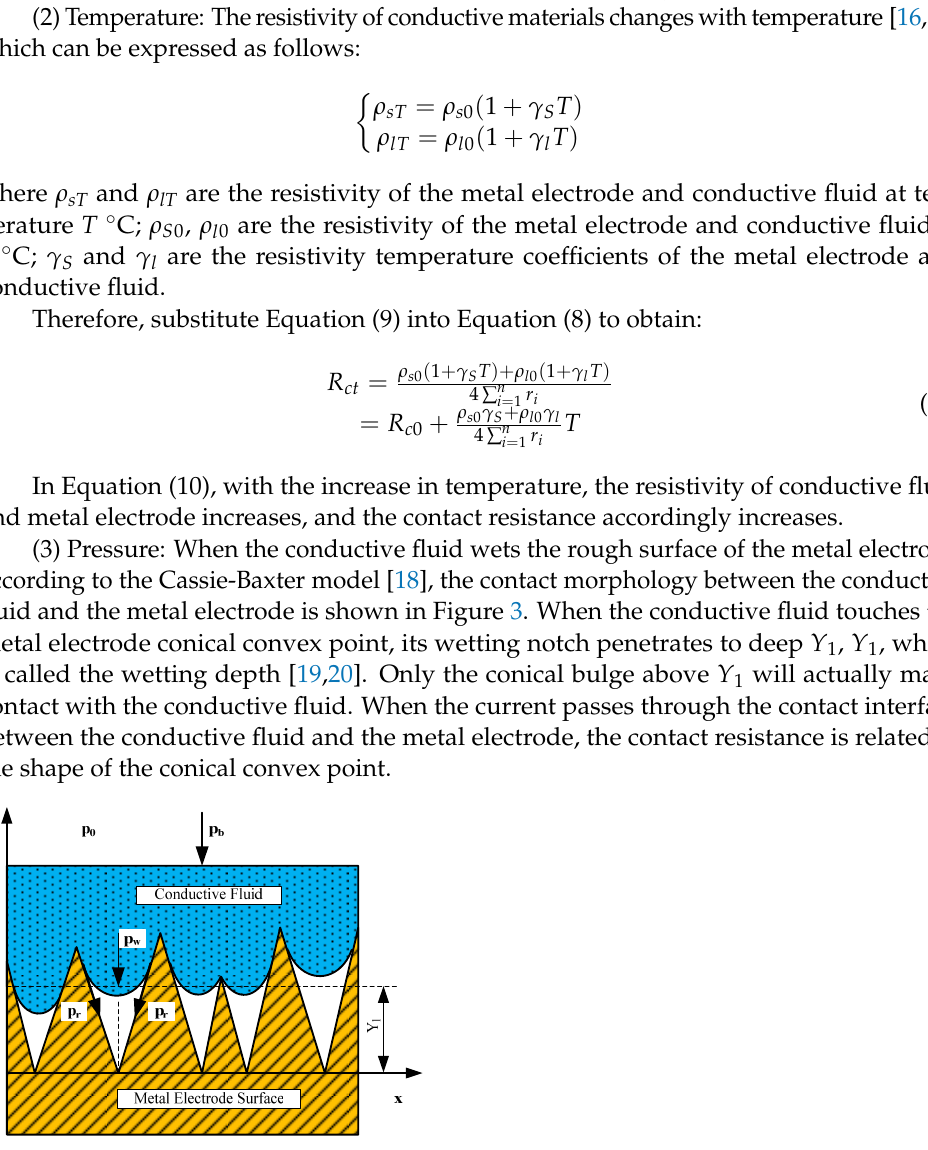
Figure 3. Schematic diagram of contact morphology between conductive fluid and rough surface. (4) Angular vibration excitation: Under the angular vibration excitation, the conduc ‐ tive fluid and the metal electrode have relative motion, which causes the change in contact area and the change in contact resistance [22–26]. Angular vibration is set to 𝑠𝑖𝑛(cid:4666)2𝜋𝑓 𝑡(cid:4667) , U 𝛺 (cid:3404) 𝐾𝑈 r and f r , respectively. Angle vibration excitation, input voltage am (cid:3053) (cid:3045) (cid:3045)